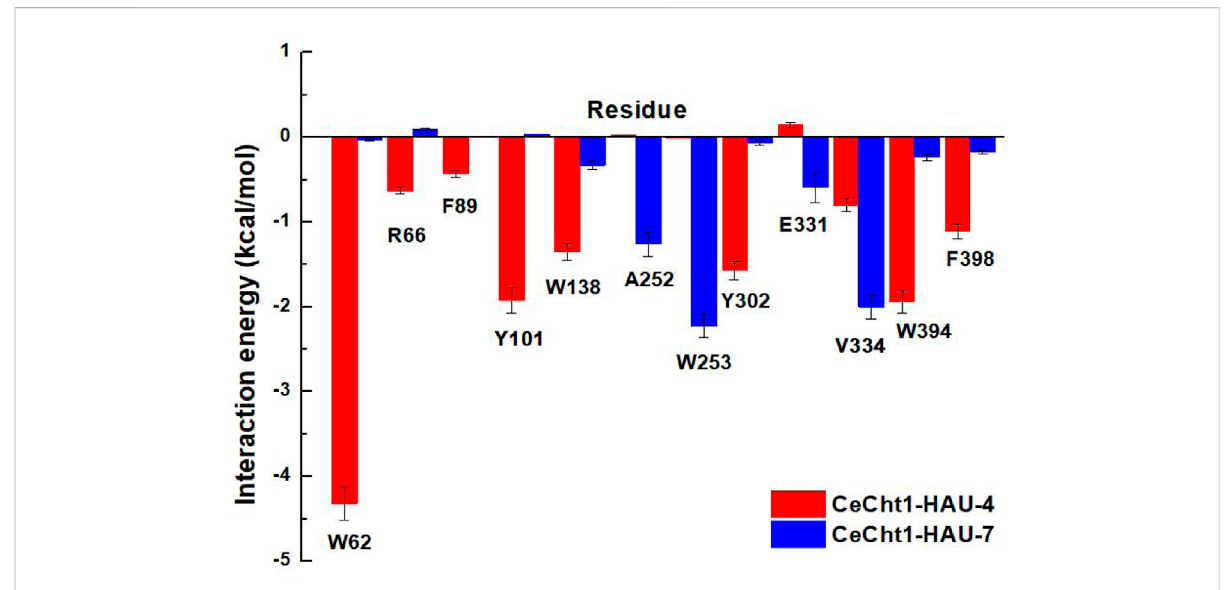
FIGURE 5 Decomposition free energy of Ce Cht1 with HAU-4 and HAU-7 calculated by MM-GBSA.